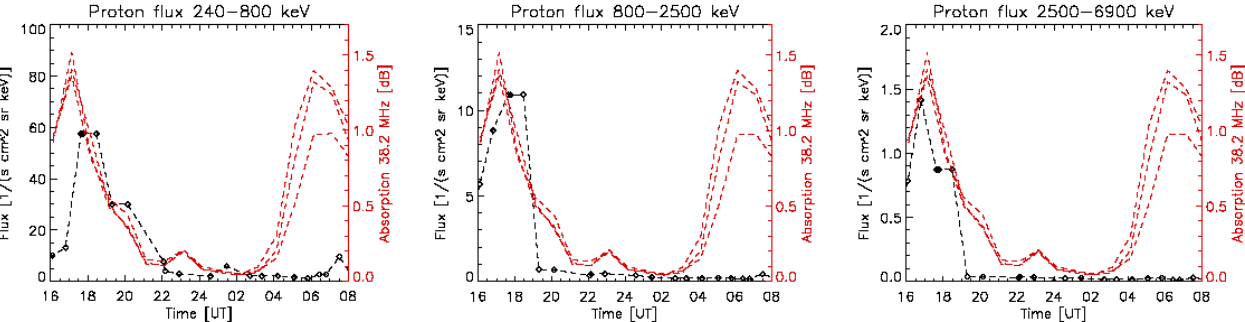
Fig. 5. The black diamonds show the proton flux in three energy channels, 240–800keV, 800–2500keV, and 2500–6900keV above Andøya found by interpolating measurement from the MEPED vertical detector on NOAA 15, 16, and 17 on 21–22 January 2005. The red dashed lines show the cosmic radio noise absorption measured by IRIS in beam 8, 15 and